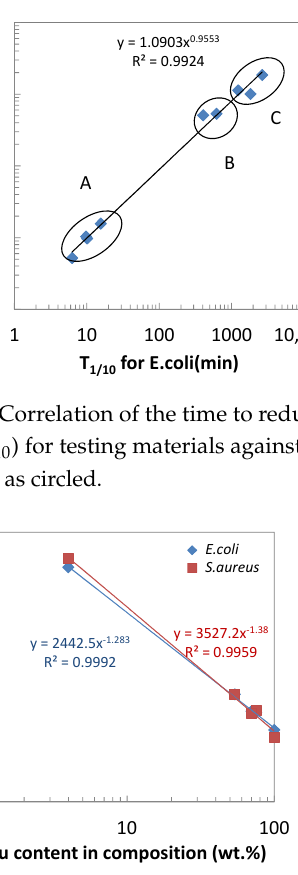
Figure 7 is the plot of the T 1/10 for E.coli against T 1/10 for S.aureus , confirming the good correlation between Gram-negative and Gram-positive bacteria. In this figure, the classification of 3 groups (A–C) is identified as circled, indicating the higher bacterial activities of group A than others. Figure 8 plotted the T 1/10 for both kinds of bacteria against the copper content in the alloy composition. This figure suggests the higher copper content in the alloy contributes to the higher antibacterial activities.